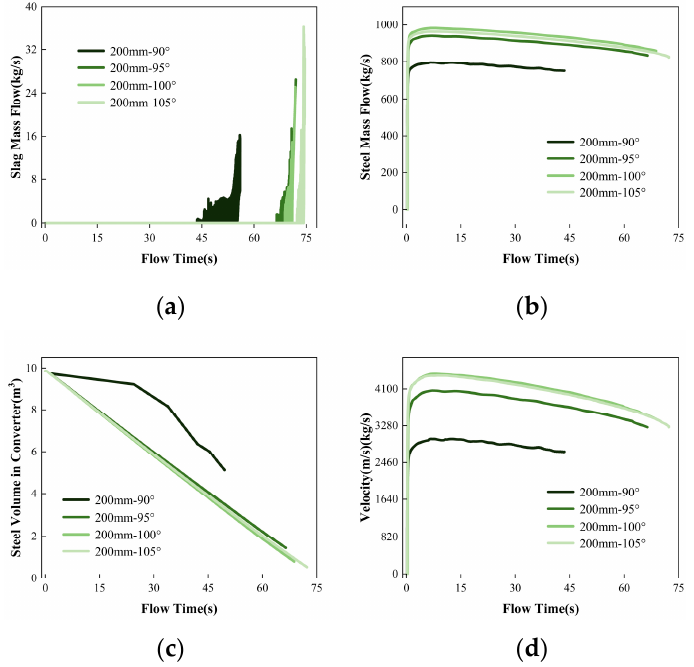
Figure 7. The variation trend of ( a ) slag mass fl ow; ( b ) steel mass fl ow; ( c ) steel volume in converter and ( d ) tapping velocity with fl owing time when the tilting angle of the converter is 90°, 95°, 100°, or 105°.